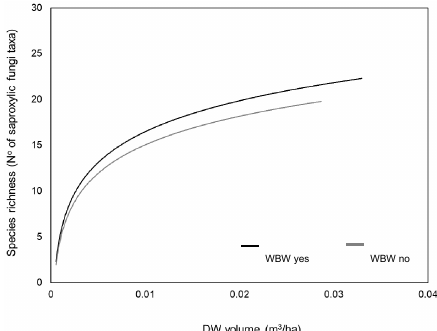
Figure 5. Rarefaction species richness curve (N o of saproxylic fungi taxa) as a function of deadwood (“DW”) volume (m 3 / ha) in WBW (black, “WBW yes”) and non-WBW territories (grey, “WBW no”).